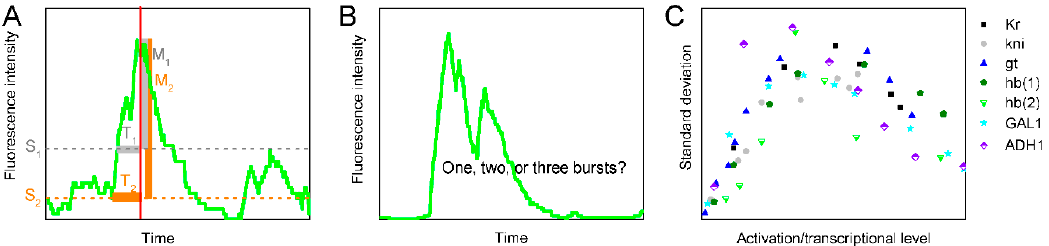
Figure 1. Schematic of technical constraints in quantifying transcriptional bursting. ( A ) The definition of signal detection threshold affects the measured burst size and magnitude. A higher signal detection threshold S1 results in a smaller burst duration (T1) and magnitude (M1) compared to that with a lower threshold (S2). ( B ) When manipulating a pulse with sub-peaks, it is artificial to take it as a single burst or a cluster of overlapping bursts. ( C ) The transcriptional uncertainty data as functions of activation/transcriptional level. Data of eight genes from [31–33] are shown. Since the definitions of units in the original studies were different, data from different sources were rescaled for the sake of clarity.